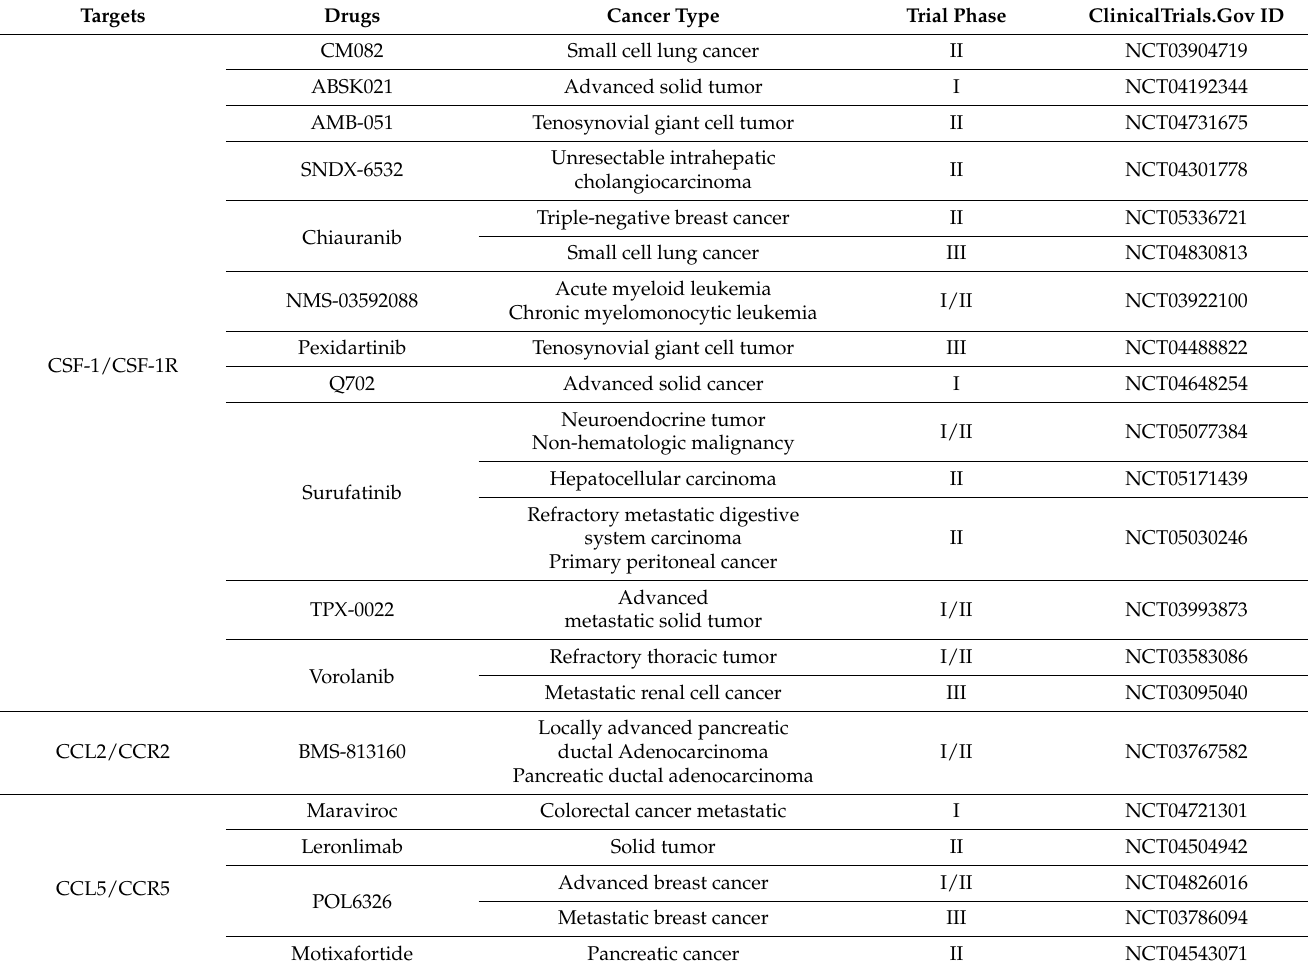
Table 4. Drugs targeting the TAM-related pathways in clinical